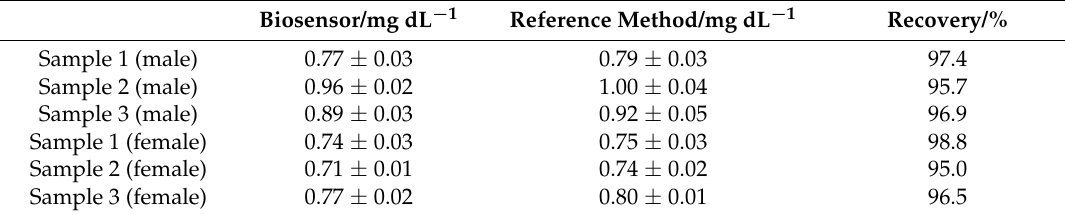
Table 4. Glucose measurements in human saliva with the Ct CDH C291Y/GA/4-APh, 4-MBA/AuNPs/GC biosensor and with the glucose oxidase-peroxidase kit (GlucoContour XT), as reference method.